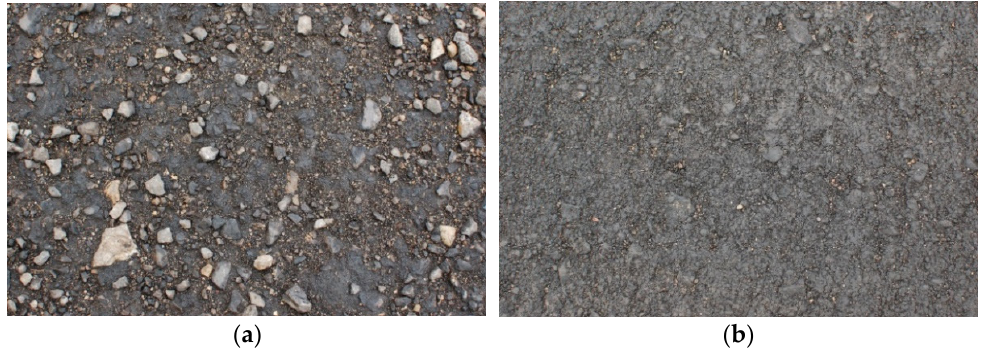
Figure 10. Granulate-based pavement surface in microscopic image ( a ) without rejuvena- tor—image of old, non-uniform structure and ( b ) with 1.3% of rejuvenator—image of rejuvenated, uniform structure. Samples were taken from the pavement of the trial road section and their contents of binder and filler were determined. However, prior to this, the determination of the grain size of the extraction was executed. For samples excavated from the pavement (wearing course), both voids content and compaction index were determined (Figure 11). Using the rejuvenator in quantities from 0.7 to 1.3% rendered meeting the requirements impos- sible [61] with regards to compaction index (>98%) and void content in samples (within the scope of 1.0–4.5%). If the rejuvenator was not used (Figure 11), the compaction index met the requirements [57], however the voids content considerably exceeded the norm (5%). The rejuvenator made the use of 100% contents of RAP in this AM recipe possible. Without it, the homogenization of the mixture components would not be possible.